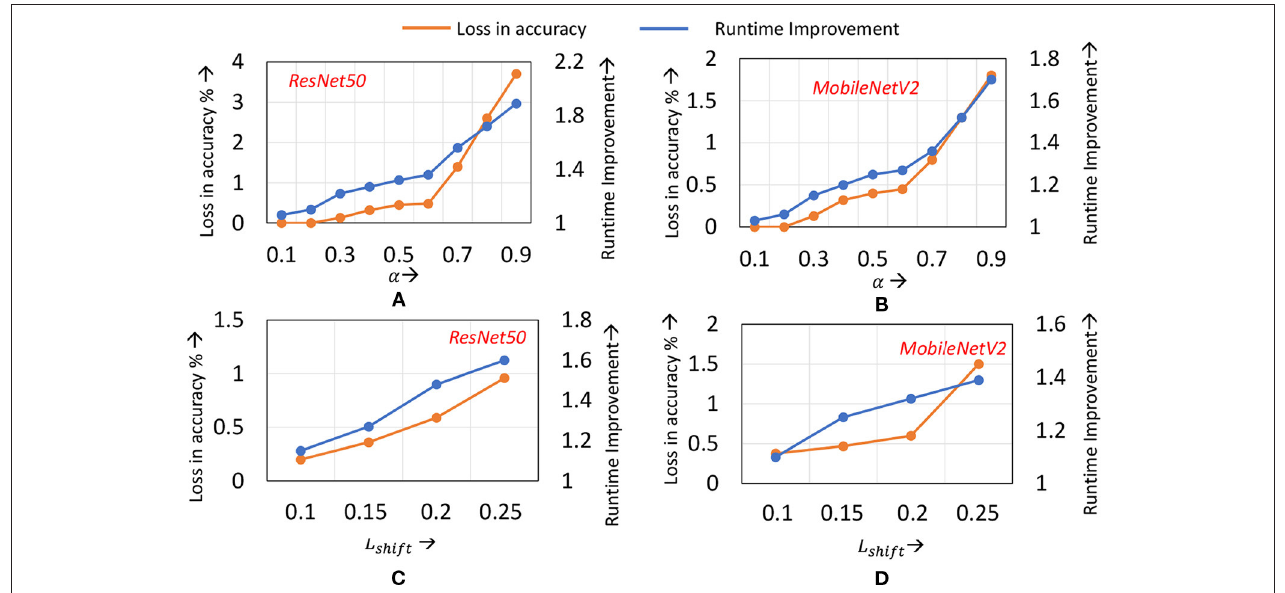
FIGURE 9 | Compute efficiency vs. accuracy trade-off on ImageNet when (A) α is varied for ResNet50 (B) α is varied for MobileNetV2 (C) L shift is varied for ResNet50 (D) L shift is varied for MobileNetV2.